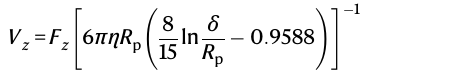
V polarization. c , d Samefor H -polarizedinput.Opticalpowertransmittedthrough the ONF was 70 mW, the gold thickness and ONF radius values are stated in the legends, the shaded bands mark the standard deviation ranges for the